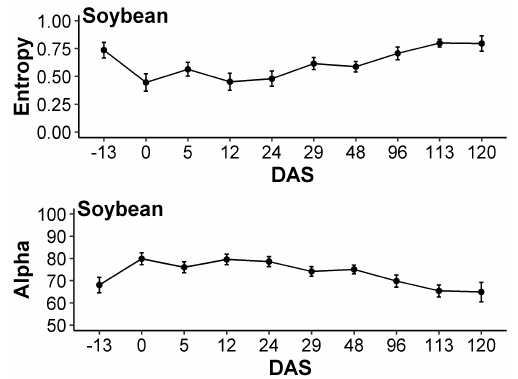
Figure 1. Mean (solid line) and standard (error bar) deviation for Height and LAI for soybean and wheat crops.